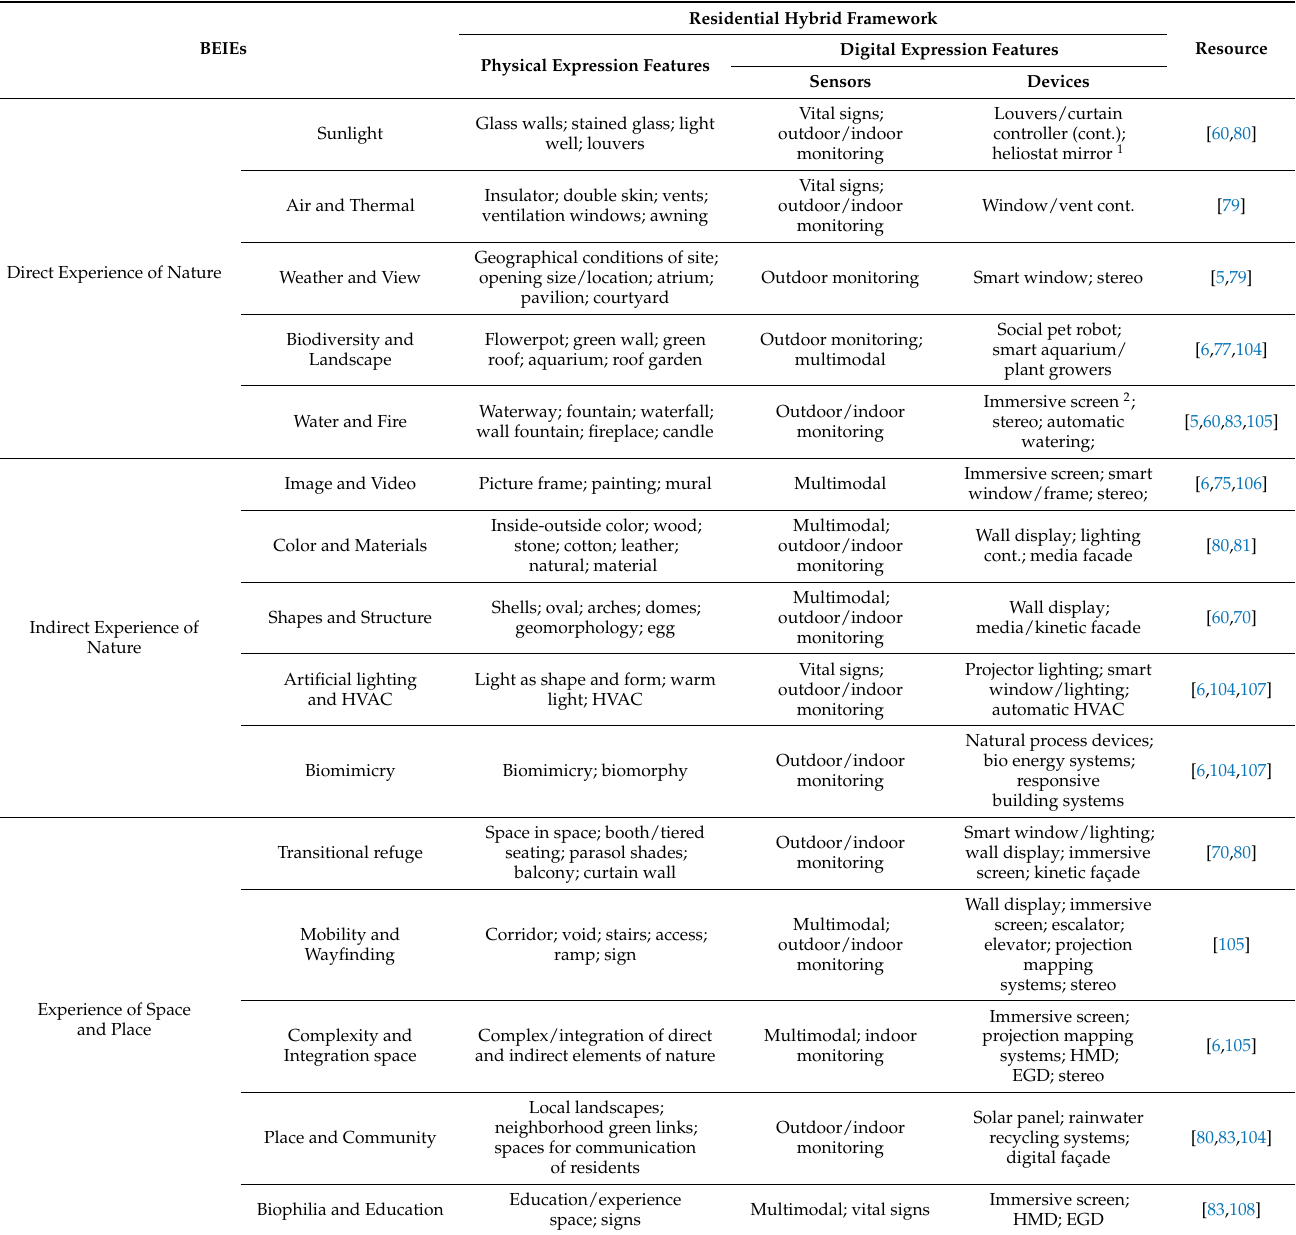
Table 4. Biophilic experience-based residential hybrid